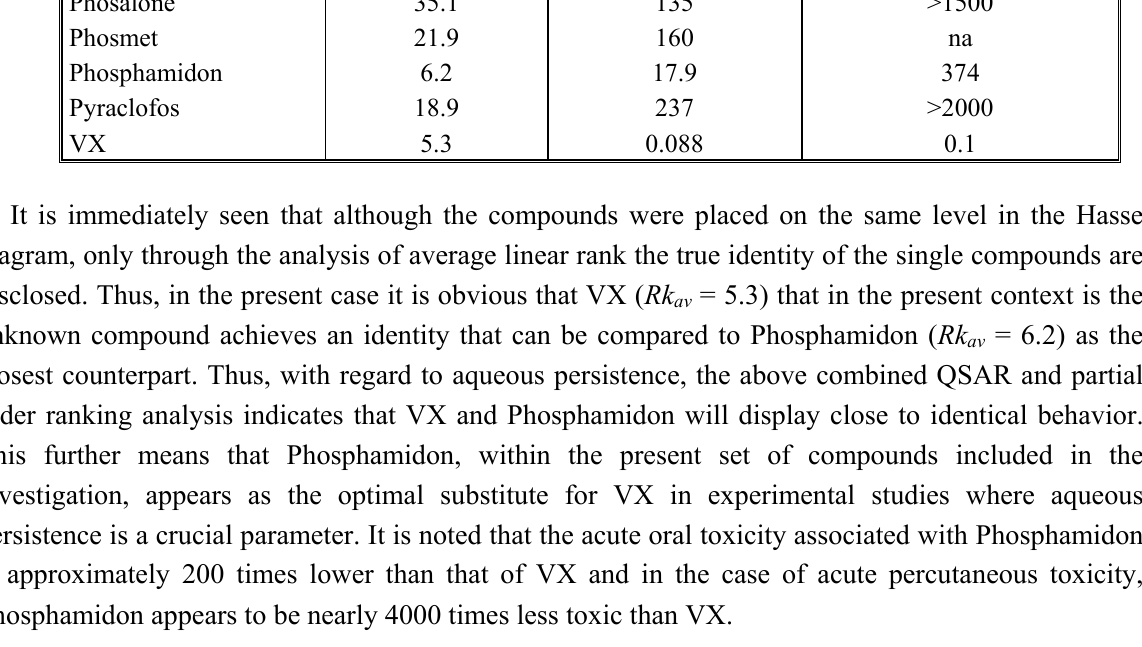
Table 1. Average ranks for the aqueous persistence as determined by the solubility, the biodegradation potential and the Henry’s Law Constants for a series of OP insecticides and VX (the compound ID refers to the FADINAP database, cf. the above text; na: not available) Acute Oral Acute Percutaneous Average Rank Compound Toxicity (mg/kg) Toxicity (mg/kg) Rk av Anilofos 20.5 472 >2000 25.6 220